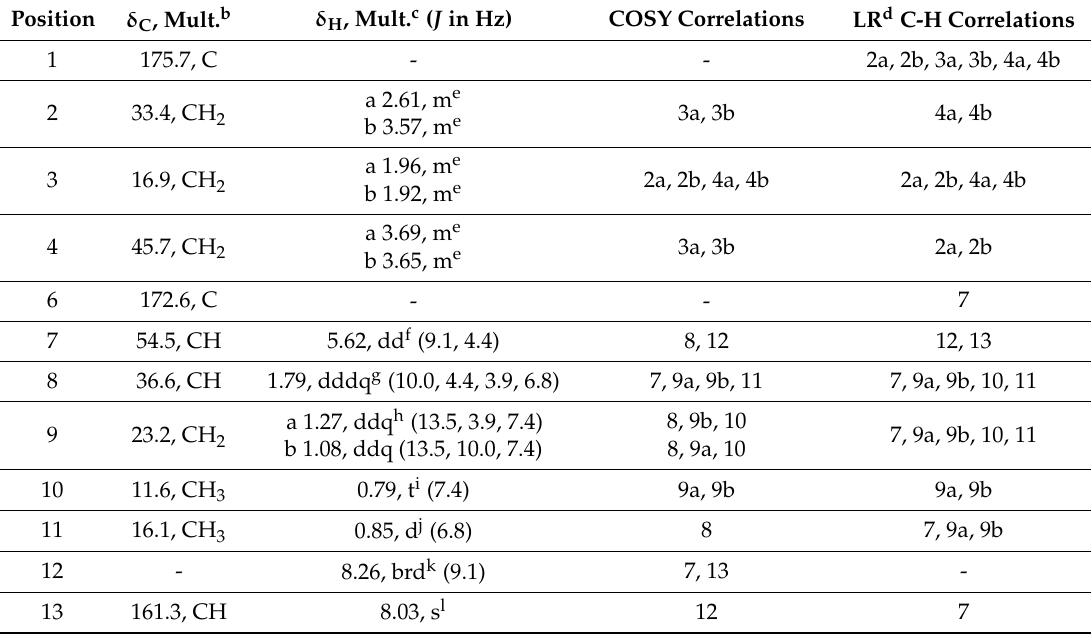
Table 2. NMR data of veronimide ( 2 ) in DMSO- d 6a